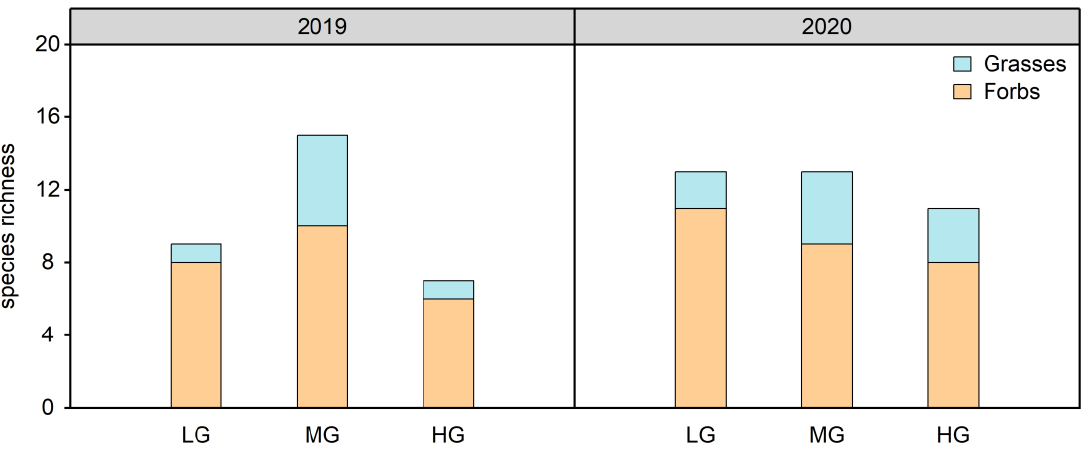
Figure 2. Species richness of the seedling bank in different grazing intensities during the two